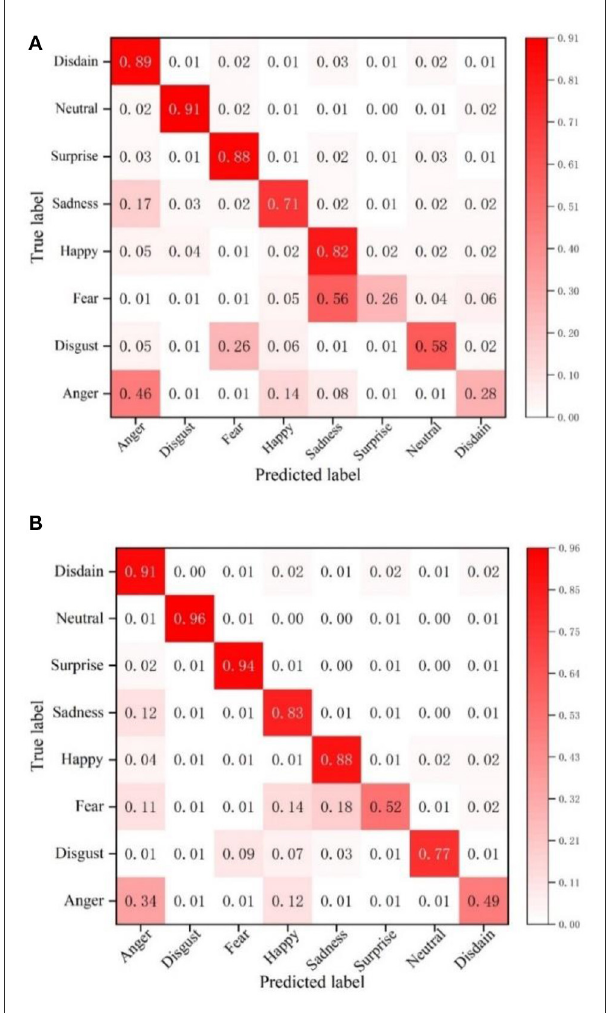
FIGURE5 Confusion matrix on the FERPlus dataset. (A) Confusion matrix of VGG16 network. (B) The confusion matrix of the model in this paper.